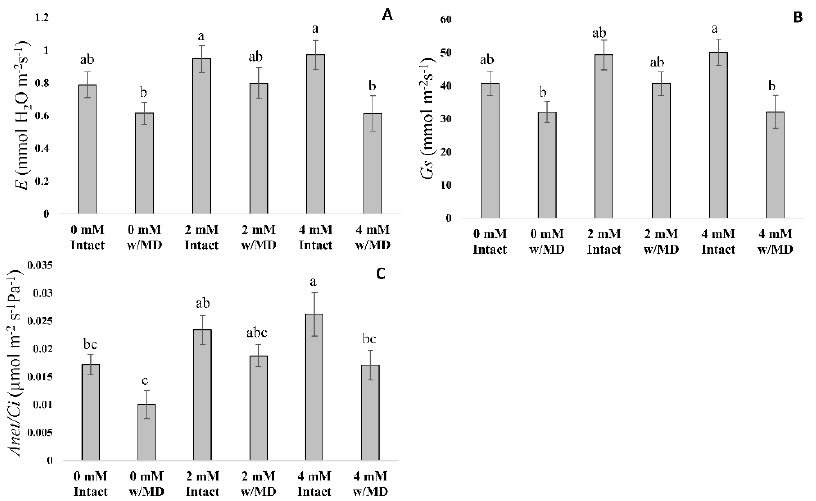
Figure 4. ( A ) Transpiration rate ( E , mmol H 2 O m -2 s -1 ) Mechanical damage p < 0.001; ( B ) Stomatal conductance ( Gs , mmol m -2 s -1 ), MD p < 0.001; ( C ) RuBisCO’s carboxylation efficiency ( A/Ci , µmol m -2 s -1 Pa -1 ), Ca x evaluation time p < 0.027, in Annona emarginata plants submitted to the treatments: 0 mM Ca 2+ without mechanical damage (intact), 0 mM Ca 2+ with mechanical damage (w/MD), 2 mM Ca 2+ intact, 2 mM Ca 2+ w/MD, 4 mM Ca 2+ intact, and 4 mM Ca 2+ w/MD, at evaluation times 0 (30 min) 15, 30, 60, and 90 days. Values correspond to means ± SE ( n = 20). Lowercase letters indicate differences between treatments within each evaluation time and uppercase indicate differences between each treatment over evaluation time. Lowercase letters indicate the differences between the treatment and capital letters between evaluation times.